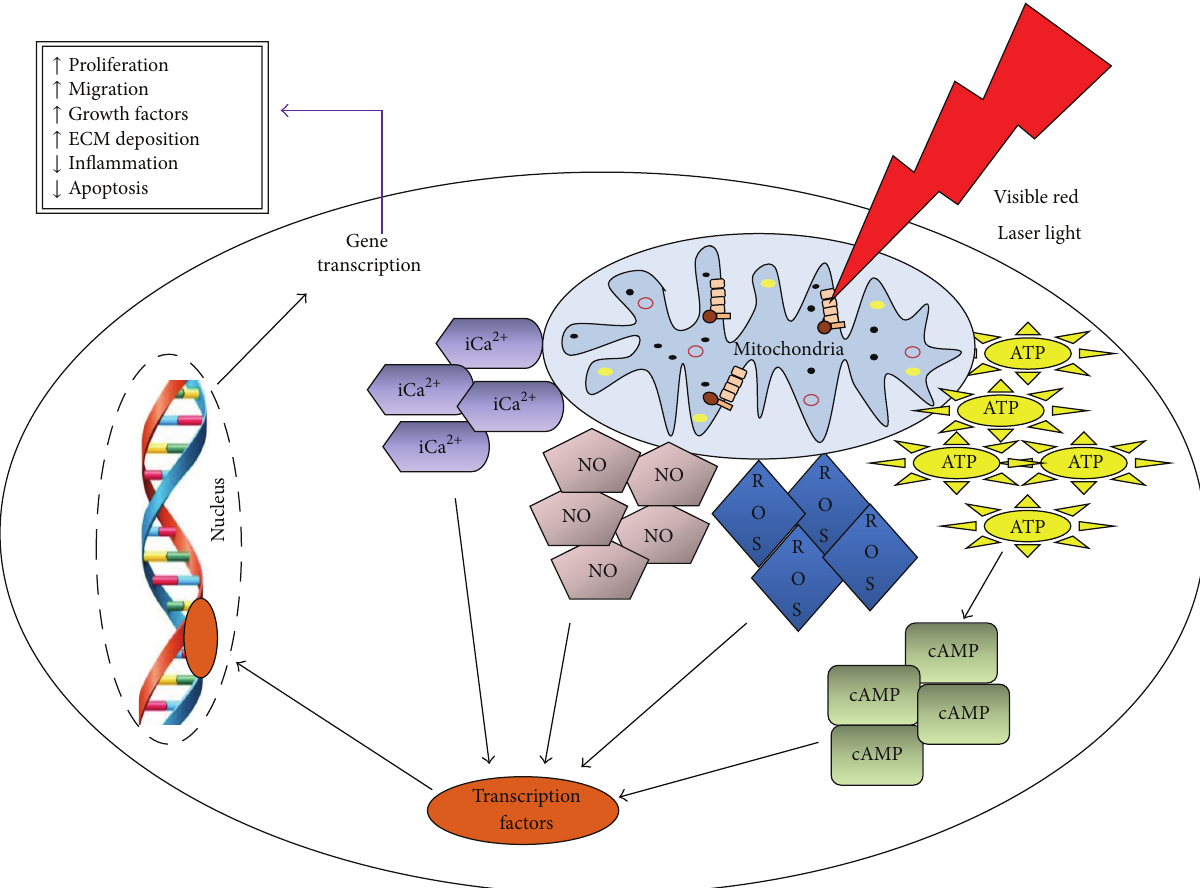
Figure 2: Laser light is absorbed by chromophores in the cell, mitochondria in the case of visible red light. This leads to an increase in adenosine triphosphate (ATP), reactive oxygen species (ROS), nitric oxide (NO), and intracellular calcium (iCa 2+ ). There is an activation of transcription factors which get translocated to the nucleus and activate gene transcription. This leads to increased cell survival and wound